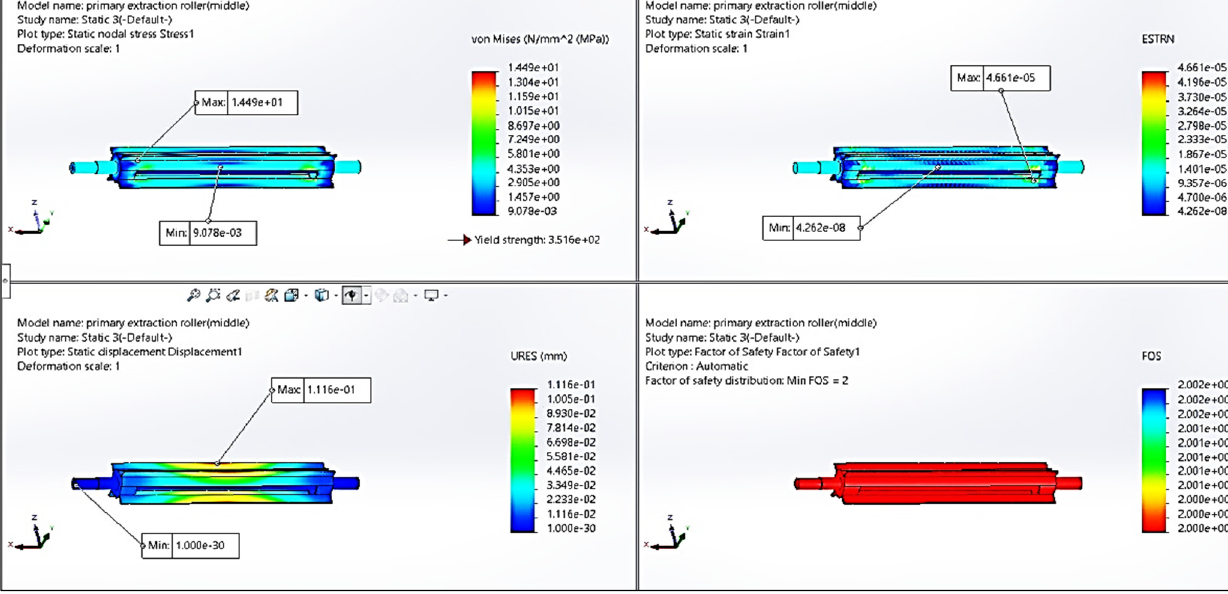
Figure 14. Stress, strain, displacement, and factor of safety of secondary extraction roller with a 200 N force considered . 3.2. Performance of the Aashkol and KP Model Jute Fiber Extraction Machine on Different Jute Types Both jute stem input capacity and ribbon output capacity were significantly affected by the jute extraction machine and jute types; however, their interactions were not signif- icant (Table 3). Comparing among jute types, the jute stem input capacity of the Aashkol was 47.63% higher than the KP model. Comparing between the extraction machines, the